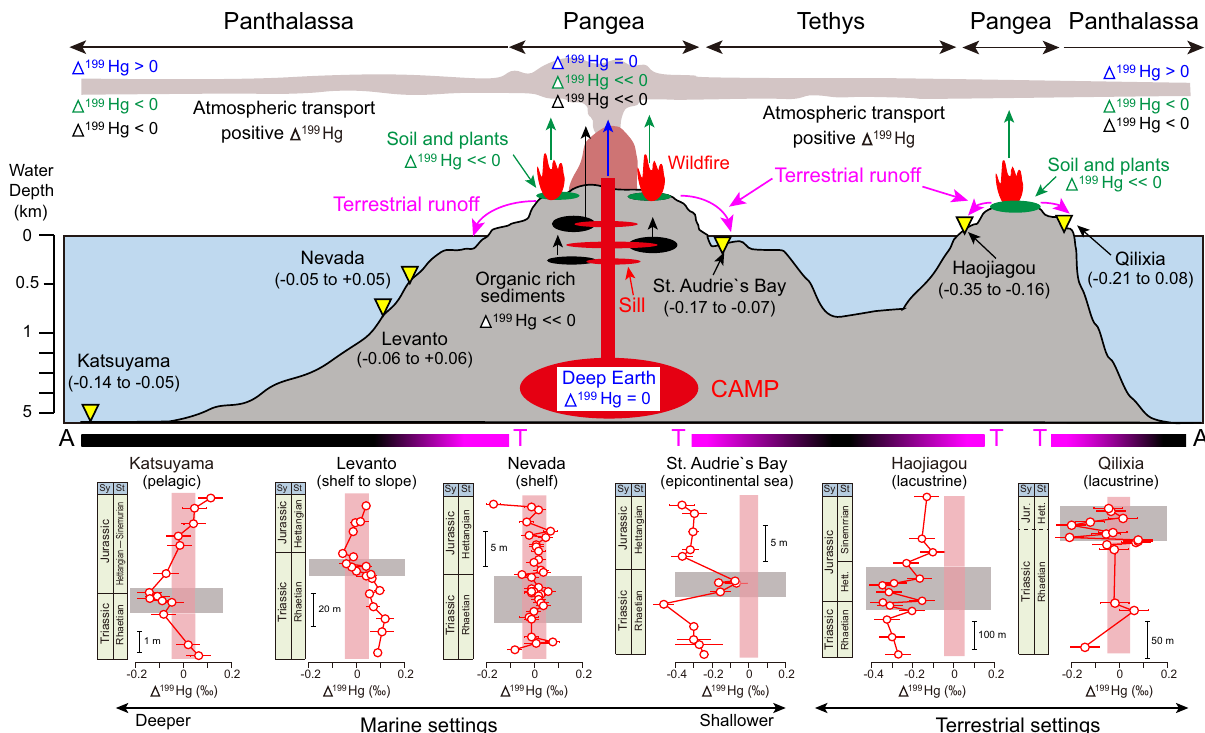
Fig. 4 Schematic illustration of Hg cycle during the T – J transition. Blue, green, and black vertical arrows represent Hg sourced from the deep Earth ( Δ 199 Hg = 0 ‰ ), soil and plants (negative Δ 199 Hg), and organic-rich sediments (e.g., coal, negative Δ 199 Hg), respectively 16,71 . Δ 199 Hg > 0 ‰ , <<0 ‰ , and <0 ‰ represent positive, strongly negative, and weakly negative values of Δ 199 Hg. Numbers in brackets below the four sections represent Δ 199 Hg values of the MEI in units of ‰ . The black and pink bars at bottom represent the atmospheric (A) and terrestrial (T) compositions of Hg at various sites in the Panthalassic and Tethys oceans. Horizontal bars of the Δ 199 Hg pro fi les represent standard deviation (2 σ ) values. Data sources by setting: pelagic (Katsuyama, this study); shelf to slope (Levanto 18 , Nevada 17 ), epicontinental sea (St. Audrie ’ s Bay 18 ), and terrestrial (Haojiagou and Qilixia 19